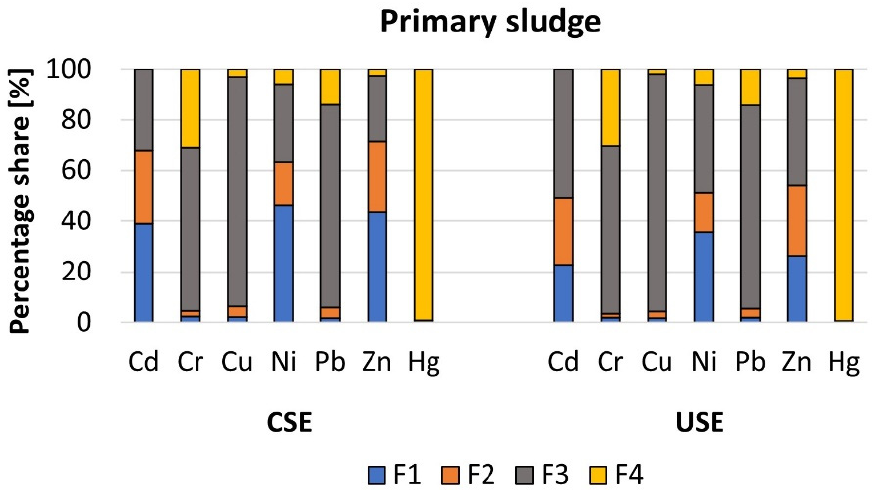
Figure 4. Percentage share of heavy metals in different chemical fractions of primary sludge.